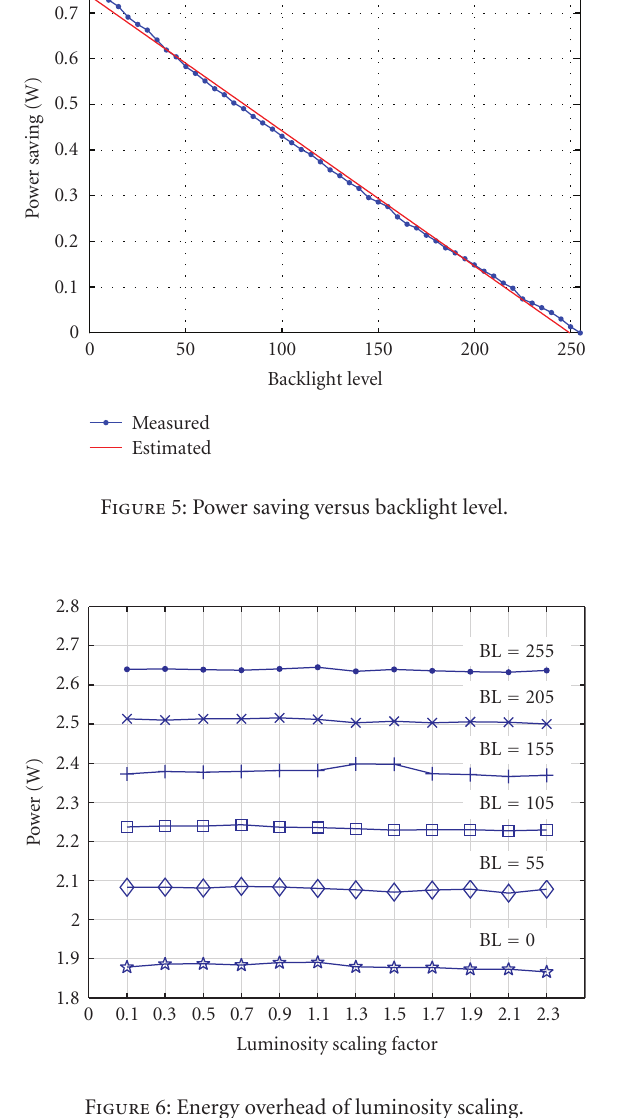
Figure 6: Energy overhead of luminosity scaling.